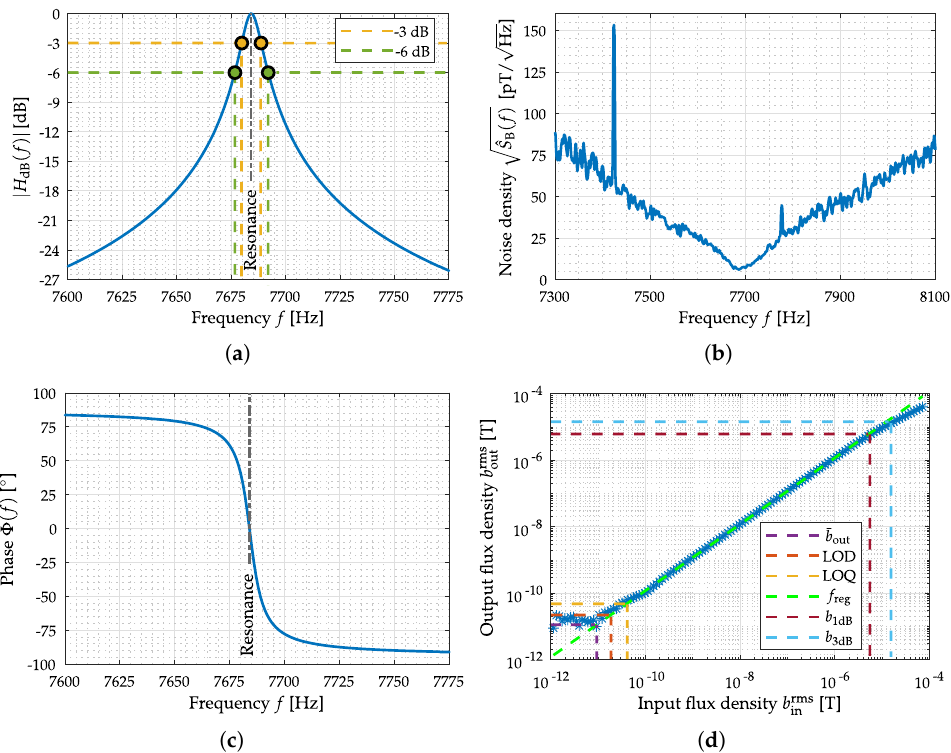
Figure 11. Measurements for the evaluation of the exchange bias magnetoelectric sensor system. In ( a ) the amplitude response and in ( c ) the phase response of the sensor system near the mechanical resonance are depicted. The noise measurement equalized with amplitude response is shown in ( b ). The Input–Output–Amplitude–Relation of the sensor, with an external magnetic field at f = f res , is depicted in ( d